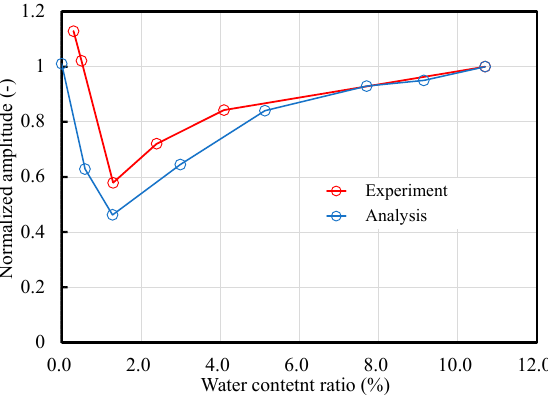
Figure 12. Relationship between the moisture content ratio and normalized amplitude.